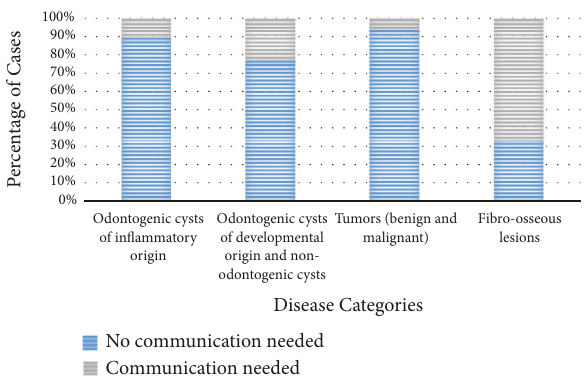
Figure 2: Comparison of percentage of cases that did and did not require communication between oral and maxillofacial pathologist (OMFP) and oral and maxillofacial radiologist (OMFR) in relation to disease categories.